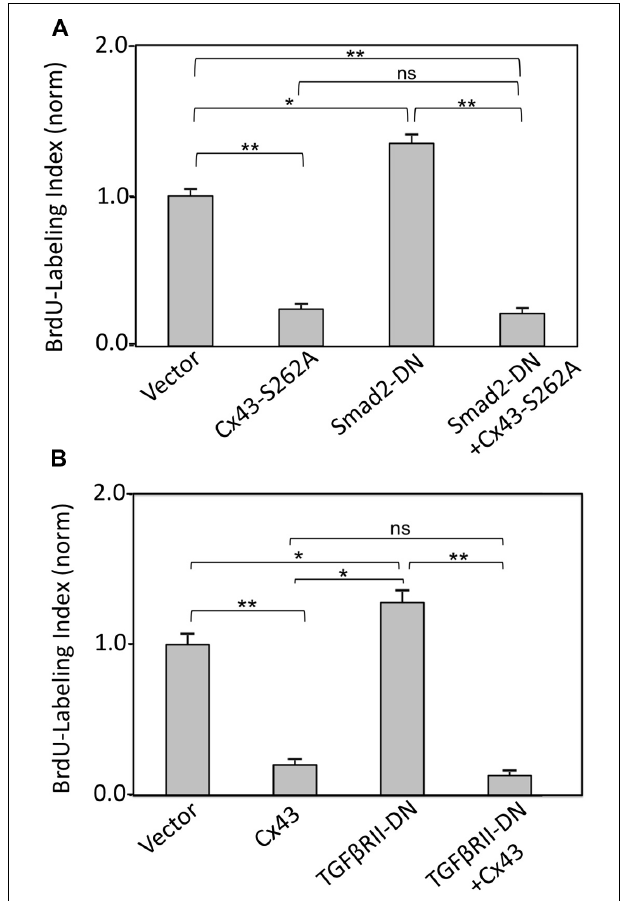
FIGURE 4 | (A) Inhibition ofTGF β RII does not affect suppression of DNA synthesis by Cx43 overexpression.The y -axis shows normalized BrdU labeling index of cardiomyocytes transduced with an empty adenoviral vector (Vector) or adenoviral vectors expressing Cx43,TGF β RII-DN, alone or in combination, as indicated. (B) Inhibition of Smad2 does not affect suppression of DNA synthesis by overexpressed S262A-Cx43.The y -axis shows normalized BrdU labeling index of cardiomyocytes transduced with an empty adenoviral vector (vector) or adenoviral vectors expressing S262A-Cx43, or Smad2-DN, or a combination of both. Data are shown as mean + SEM; brackets indicate comparisons between groups. **, *, and ns correspond to P < 0.01, P < 0.05, P > 0.05. Expression of the transduced genes was verified by western blotting (data not